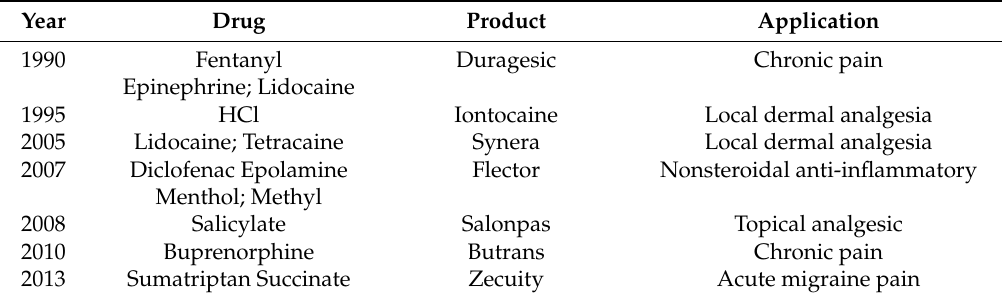
Table 2. FDA approved transdermal patches for pain